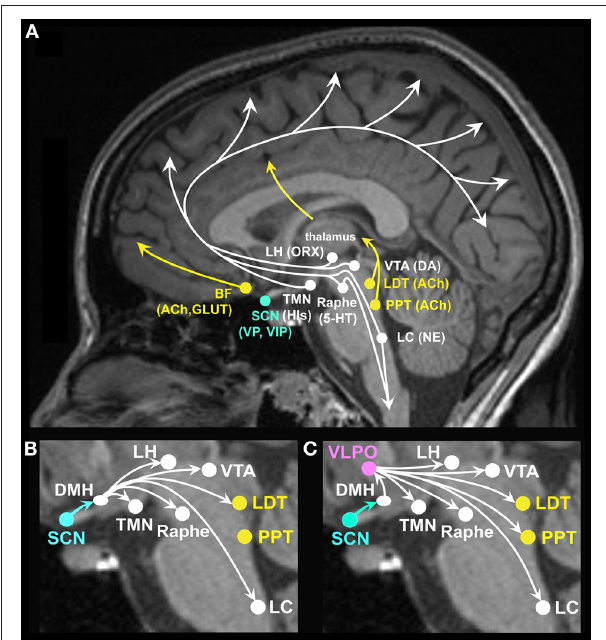
FIGURE 1 | (A) Brain arousal for neurocognitive and neuro-affective function is promoted by ascending brain stem, forebrain and hypothalamic projections to the cortex and midbrain. Neurotransmitter and neuropeptide systems involved in brain arousal and therefore in cognitive and affective function include the monoaminergic neurotransmitters histamine (His) from the tuberomammillary nucleus (TMN), norepinephrine (NE) from the locus coeruleus (LC), serotonin (5-HT) from the midbrain raphe nuclei, dopamine (DA) from the ventral tegmental area (VTA), and substantia nigra (not shown); the cholinergic neurotransmitter acetylcholine (ACh) from the basal forebrain (BF) and the pedunculopontine (PPT), and laterodorsal tegmental nuclei (LDT); the peptide orexin (ORX), also referred to as hypocretin, from the lateral hypothalamus (LH); the excitatory amino acids glutamate (GLUT) and aspartate; vasopressin (VP), and vasoactive intestinal polypeptide (VIP) from the suprachiasmatic nuclei (SCN). (B) The master circadian clock located in the SCN has modulatory input to many of the ascending arousal pathways, some through direct projections from the SCN (not labeled, see text) and many through indirect projections relayed by the dorsomedial hypothalamus (DMH). Through such projections, the SCN can modulate circadian rhythms in brain arousal to promote wakefulness. (C) The SCN has modulatory input to the sleep systems via relay projections to the DMH, onto the sleep promoting VLPO as well as midbrain and brain stem arousal systems. Through such projections, the SCN can modulate circadian rhythms in brain arousal to promote